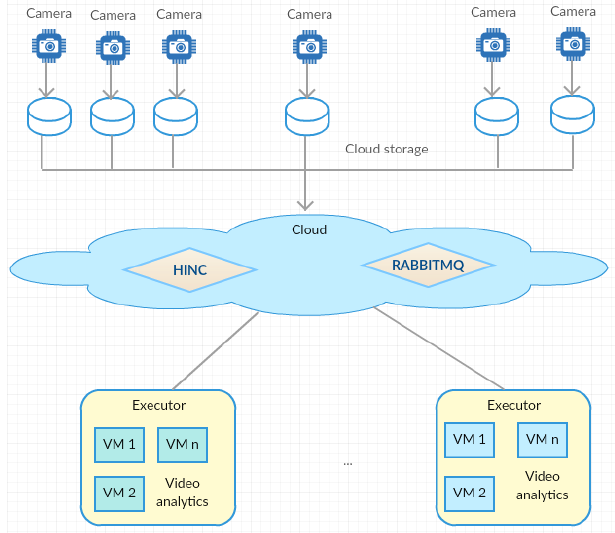
Figure 2. Video analytics paradigm